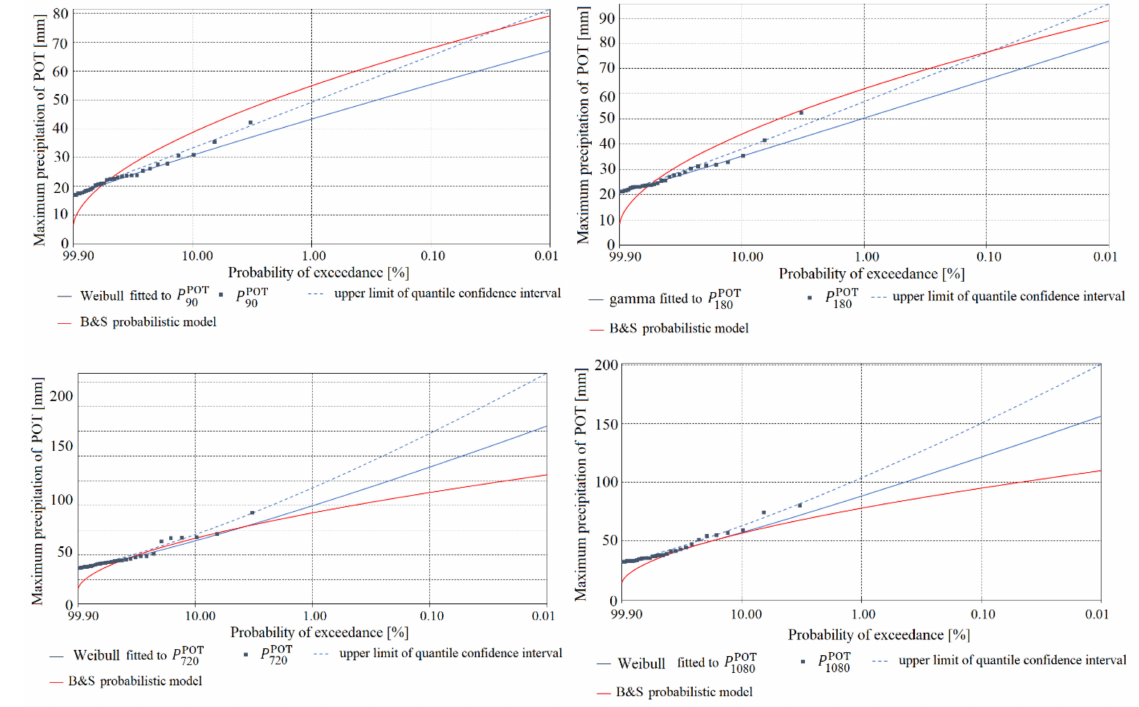
Figure 9. Plots of functions of probability of exceedance for the random variables P POT τ where τ = {90, 180, 720, 1080} min, for the most credible probability distributions, with indication of upper limits of quantile confidence intervals according to the PMAXTP method, compared with the model of Bogdanowicz and Stach ý , for the Bialystok meteorological station.